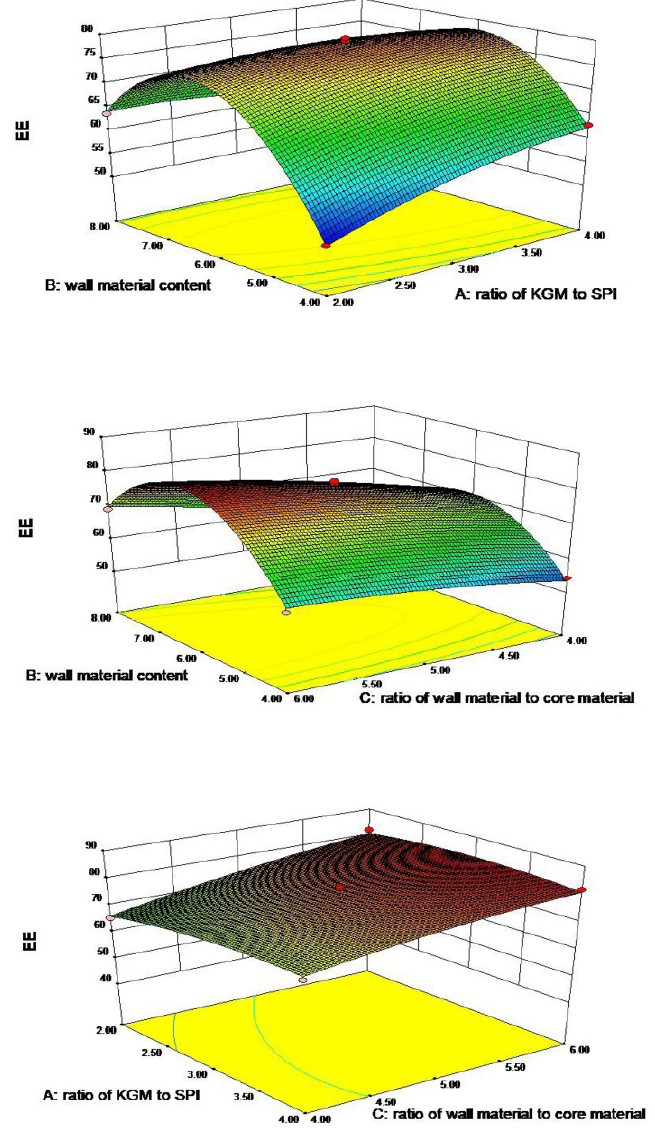
Figure 1. Three-dimensional response surface of encapsulation efficiency affected by the ratio of KGM to SPI ( A ), wall material content ( B ) and the ratio of wall material to core material ( C ).